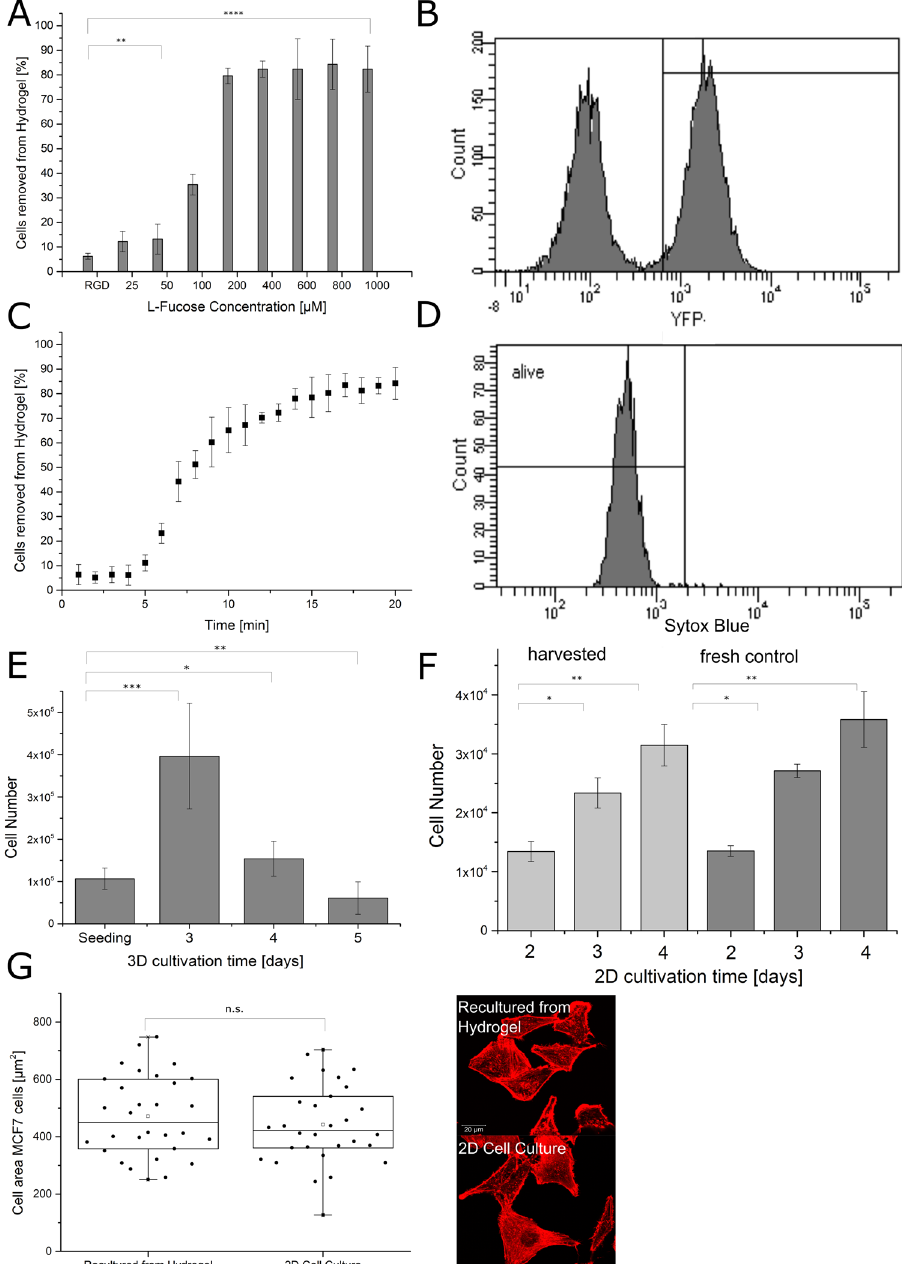
Figure 5. Release of A549 cells from the hydrogels. Hydrogels were polymerized and freeze-dried as described earlier and decorated with YFP-LecB. Cells were seeded into the hydrogels and incubated for 2 h to guarantee cell adhesion. ( A ) Cell loaded hydrogels were incubated with different concentrations of L-fucose and about 90% of cells could be released with 100 µ M of L-fucose. ( B ) YFP-LecB after elution of the cells. Flow cytometry analysis was conducted, revealing that about 50% of all cells still bear YFP-LecB on the surface. ( C ) Cell-loaded gels were incubated with 100 µ M of L-fucose, samples were taken at regular intervals and cells were counted. After approx. 10 min, 90% of the cells were eluted from the matrix. ( D ) Biocompatibility of materials and procedures used. Cells were eluted from the hydrogel and cytotoxicity was investigated with flow cytometry. ( E ) Cells were seeded and grown for 3 days in the hydrogels, eluted with 100 µ M of L-fucose and counted with a Neubauer counting chamber to see proliferation of cells. ( F ) Cells were eluted from the hydrogel with 100 µ M of L-fucose and re-cultured under 2D conditions over 4 days (left side) and the growth was compared with a fresh control (right side). ( G ) Adhesion of eluted cells after being re-cultured in 2D. The right side shows the average surface area of re-cultured cells compared to a fresh control. The right side shows the actin filament of re-cultured and fresh cells to observe possible differences in their morphology. All bars represent the standard deviation. The significance was tested with a one-way ANOVA with alpha = 0.05 for Fig. 5A, E and G and with a two-way ANOVA for Fig. 5F with alpha =